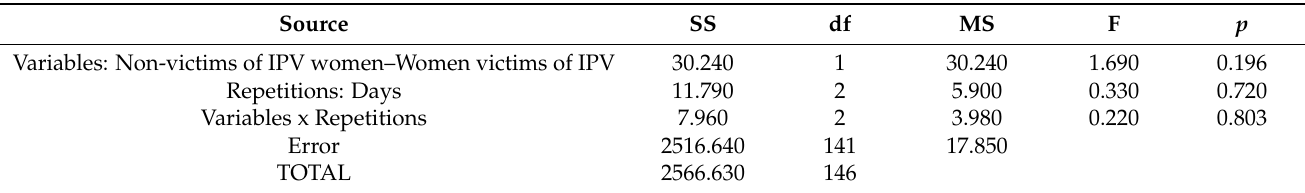
Table 3. Summary table of the ANOVA applied to the CAR data